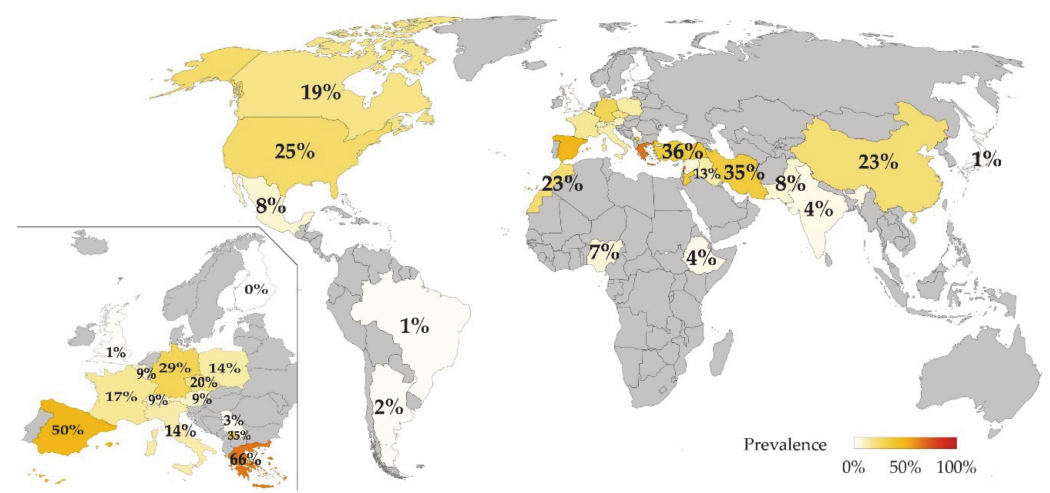
Figure 2. Individual SRLV prevalence (%) in sheep per country. Data extracted from scientific literature published from 1981 to 2020 and detailed in Table 2. Inset: Higher magnification of Europe.